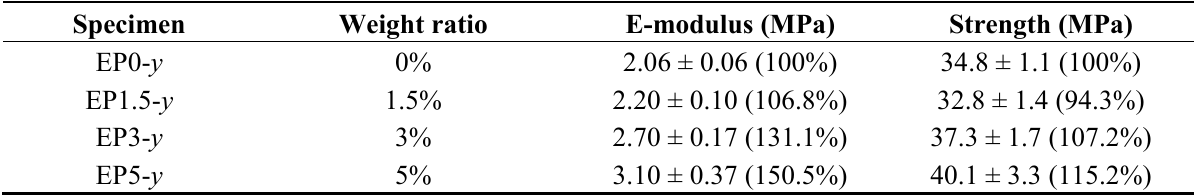
Table 2. Elastic modulus, strength and ultimate stain of modified epoxy with different weight ratios of milled carbon fibre (values are averages of three identical